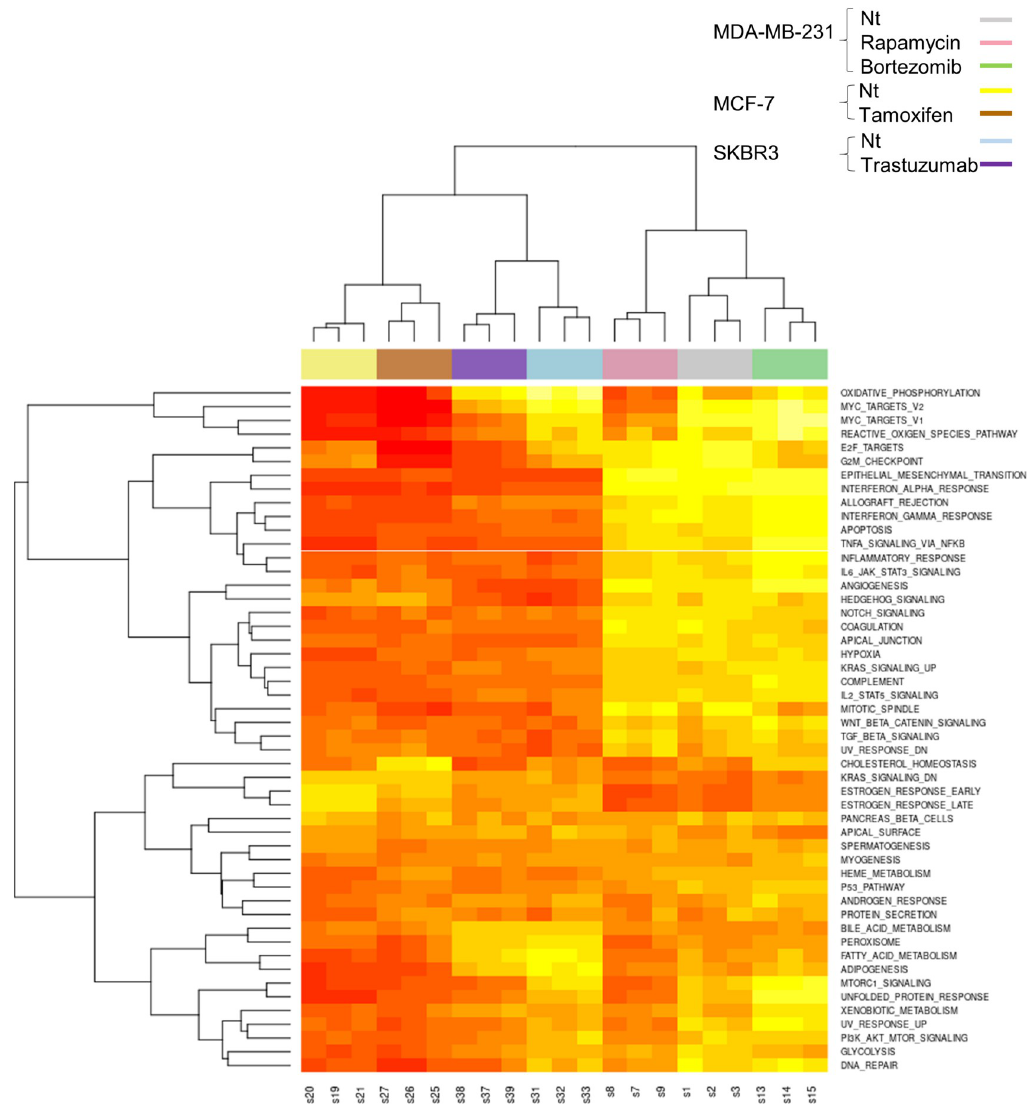
Fig 3. Drug induced gene set variation analysis and differential gene expression hierarchical clustering heatmap of gene set variation analysis enrichment scores of hallmark pathways from RNASeq data. These data included n = 3 replicates that are clustered under colored bar according to the treatment and cell